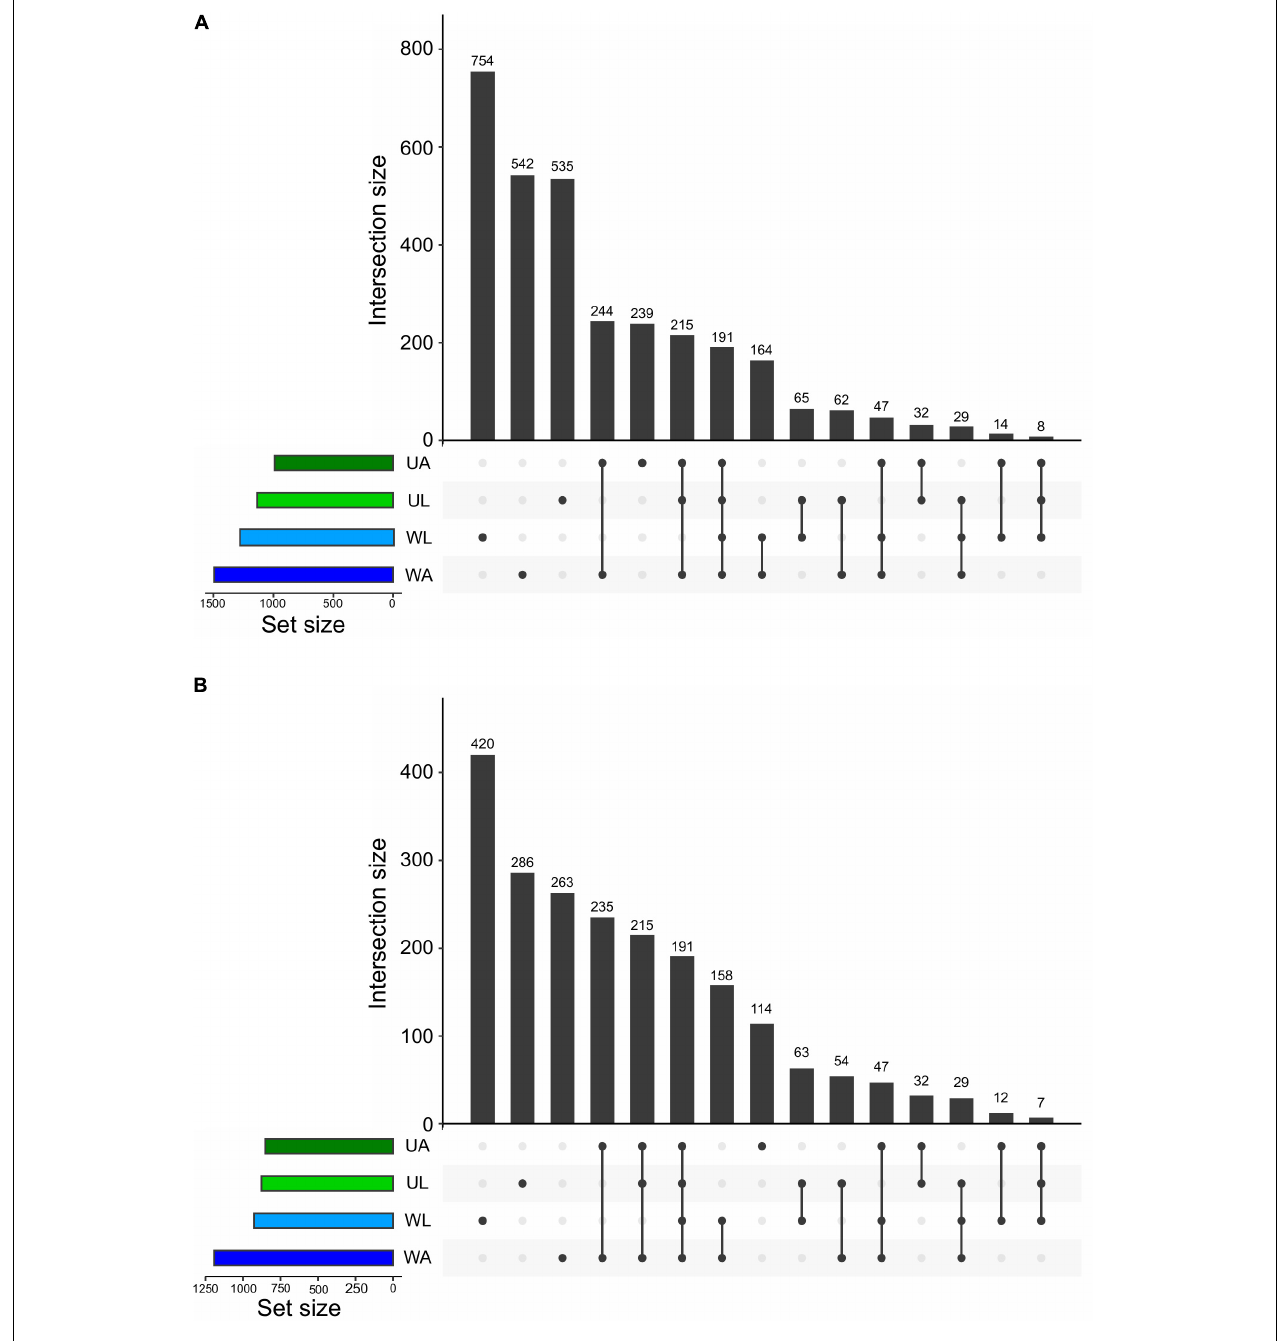
FIGURE 6 | Intersection plot showing all the unique and common ASVs across all prokaryotic communities analyzed in this study (UL, Ulva from lagoon; UA, Ulva from aquaculture; WL, water from lagoon; WA, water from aquaculture). Values at the top of vertical bars refer to the number of ASVs common to the microenvironments linked underneath, which represent the intersections. The horizontal bars on the left show the size of each prokaryotic community in terms of ASV numbers. The two graphs show the microbiomes before (A) and after (B) the removal of low abundance ASVs (with less than 10 reads across the whole dataset).